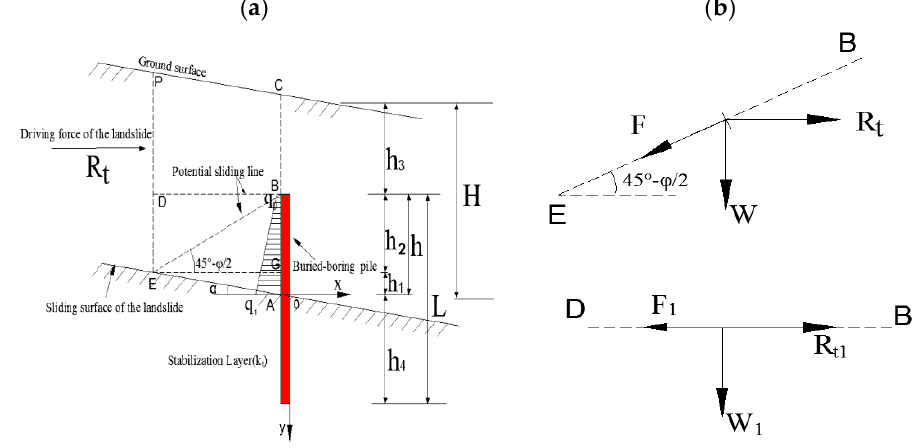
Figure 1. Calculation model of buried-boring pile: ( a ) Stress model of the pile under a trapezoidal load; and ( b ) parameters determining the equilibrium along the potential sliding surface.